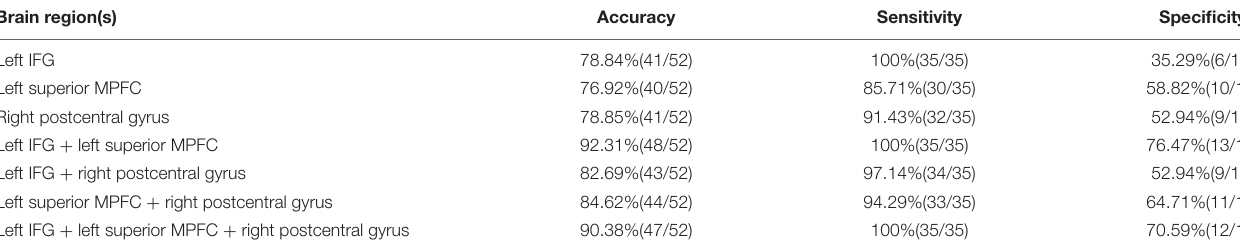
TABLE 3 | Support vector machine results of discrimination between GI-MDD patients and nGI-MDD patients by using PAS scores. Brain region(s)